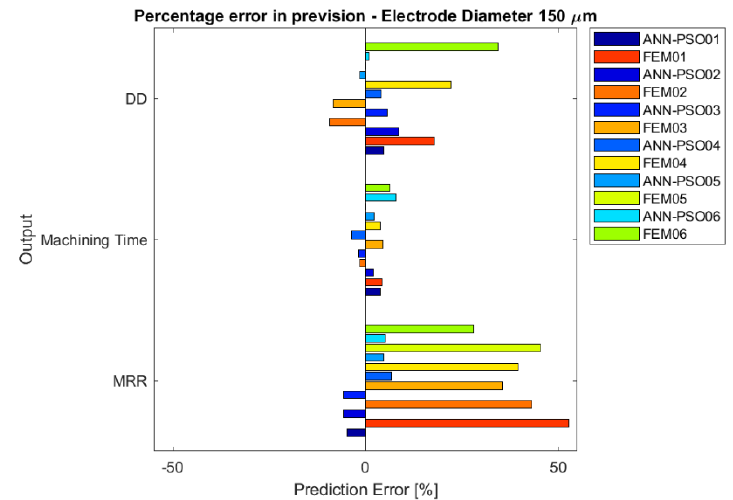
Figure 6. Bar chart of percentage error between simulation models and experimental tests, for drilling process performed by means of the electrode with a diameter equal to 150 µm.